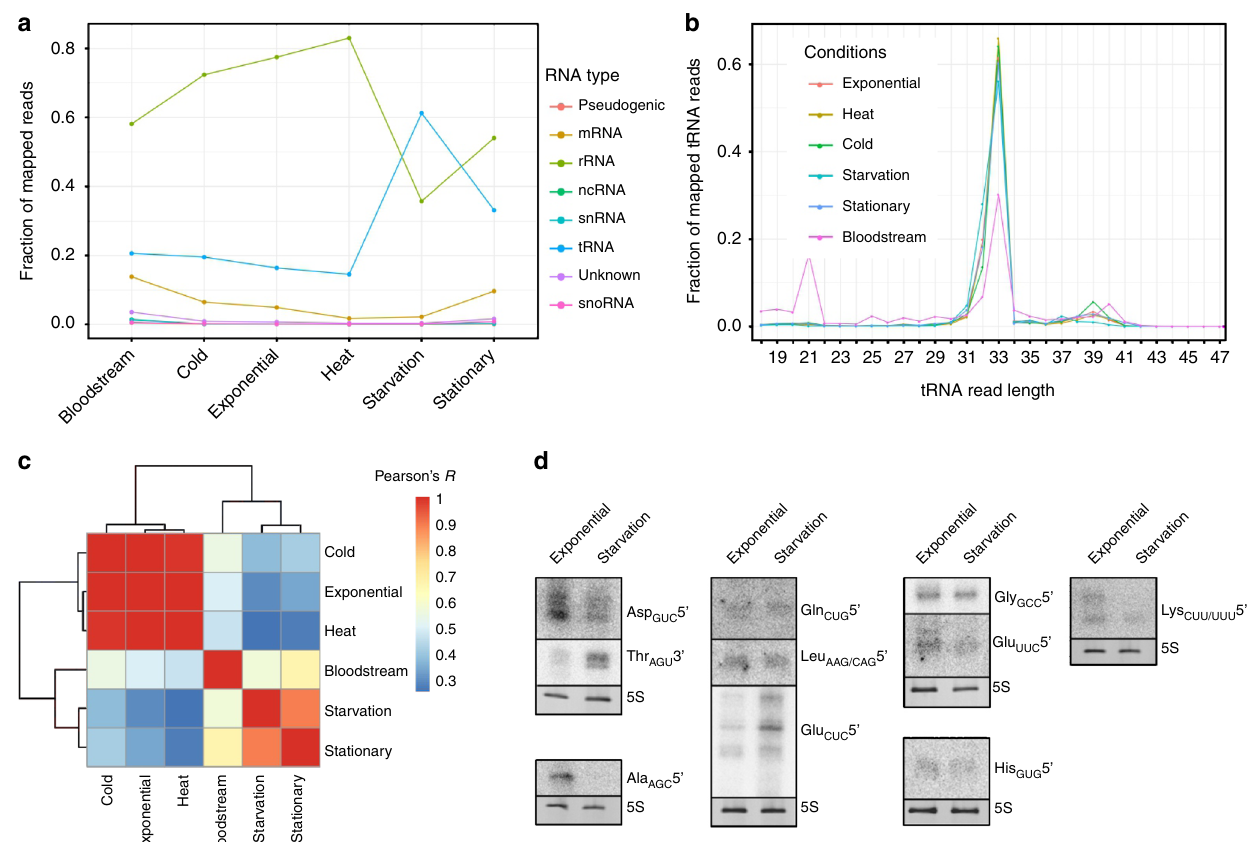
Fig. 1 Pro fi ling the abundance levels of rancRNA sequencing reads. a The distribution of sequencing reads fractions assigned to different RNA classes among different growth conditions and life stages of T. brucei . Note that the category ‘ ncRNA ’ includes annotated T. brucei ncRNAs not listed otherwise. b Read length distribution of tRNA-derived sequencing reads observed during different growth conditions. c Sample correlation matrix showing Pearson ’ s correlation of expression levels of identi fi ed tRNA processing products between different growth conditions and life stages. d Ribosome-association of tRNA halves was assessed via northern blot analyses on RNA isolated from the crude ribosomal pellet from exponentially growing cells or from cells starved for two hours by incubating the parasite in PBS. The 5S rRNA (5S) served as loading control. tRNA isoacceptor anticodons and the origin of the tRNA halve (5 ′ or 3 ′ ) are